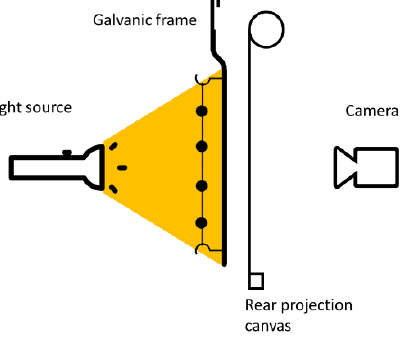
Figure 11. Rear projection setup.